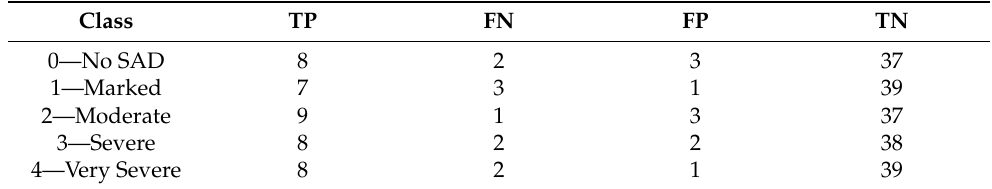
Table 6. Multi-class confusion matrix output for TP, FP, FN, and TN.